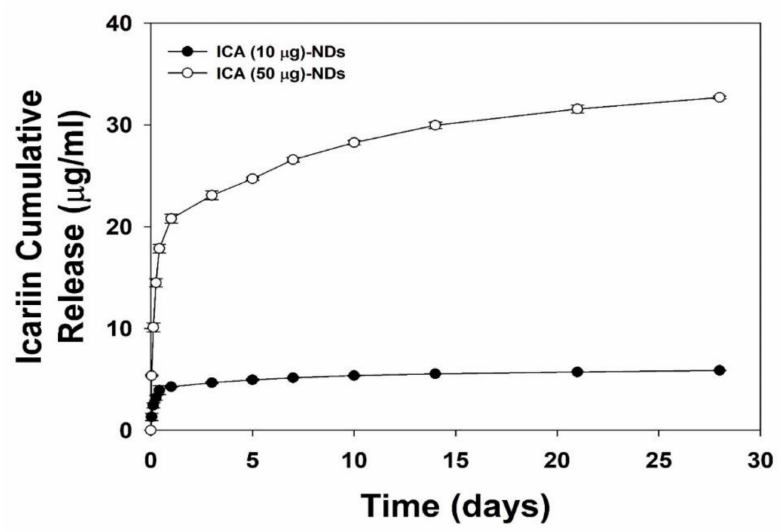
Figure 3. In vitro cumulative ICA release from the ICA (10 µ g)-NDs and ICA (50 µ g)-NDs ( n = 4 / group).